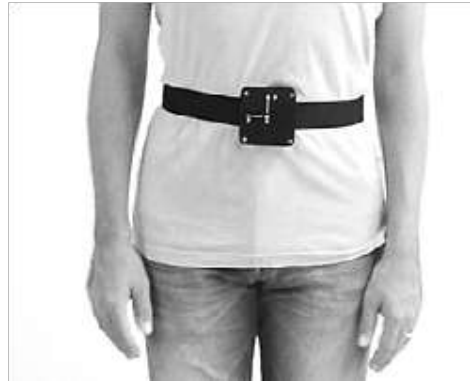
Fig. 2. Sensor placement on volunteer's body